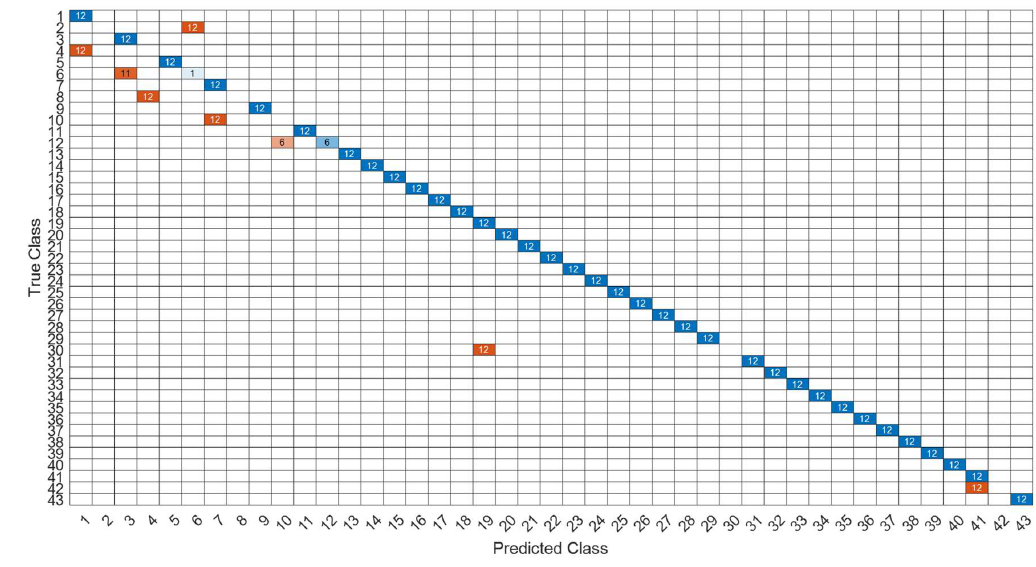
Figure 28. The confusion matrix of the DNN model with LPC 40-features dataset.